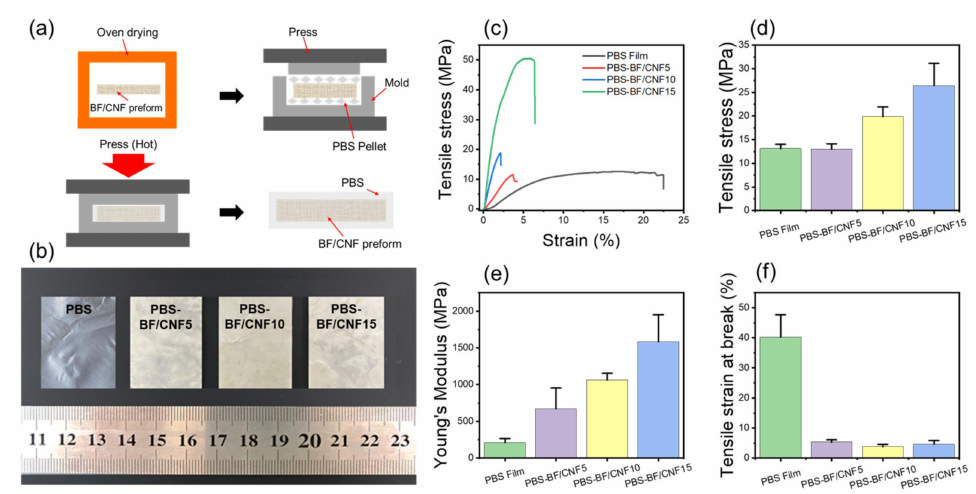
Figure 8. Mechanical properties of BF/CNF reinforced PBS composites. ( a ) Schematic of the PBS-BF/CNF composite fabrication process, ( b ) optical images of PBS-BF/CNF composites, and ( c – f ) tensile properties of PBS-BF/CNF